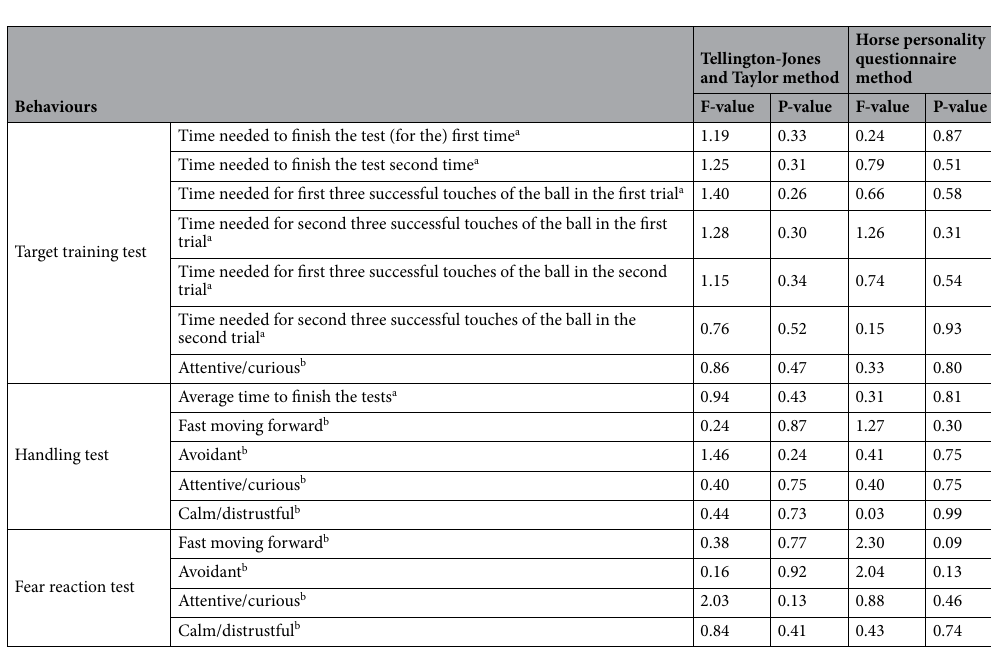
Table 3. The ANOVA test for groups of horses that had comparable responses to three behavioural tests, for head characteristics based on Tellington–Jones and Taylor descriptions and for the questionnaire data. a Values represent latencies, measured in seconds (s). b Values represent percentage (%) of the total testing time.